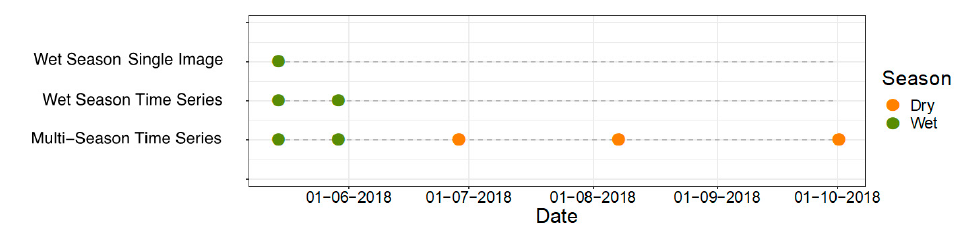
Figure 2. Timeline of image acquisition. The combination of images used for each of the three image sets is also shown.